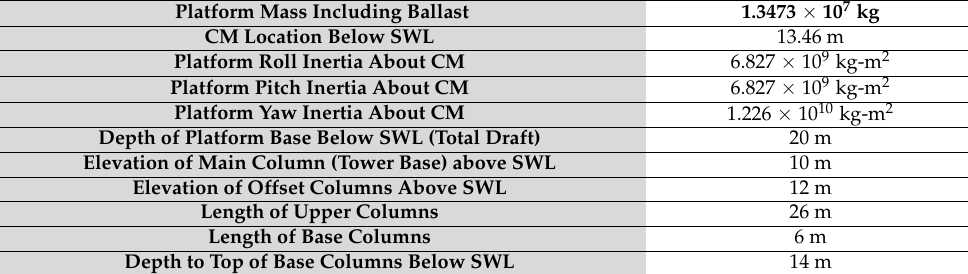
Table 3. Floating platform structural (OC4 semi-submersible) properties (source from: [19]).